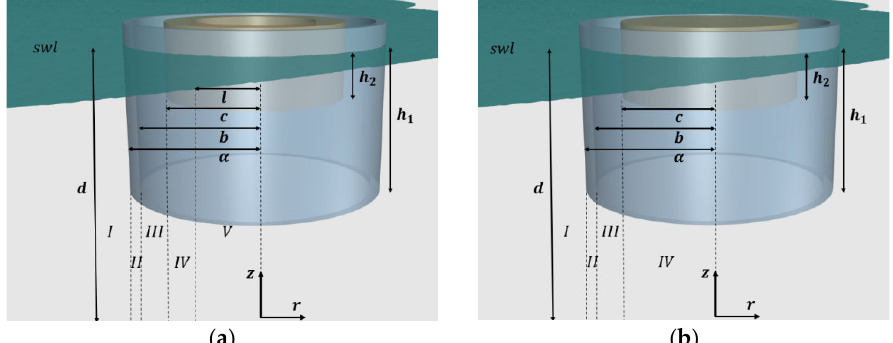
Figure 1. Two examined moonpool case studies exposed to the action of regular wave trains. Definitions and discretization of the flow field around the bodies: ( a ) two coaxial surface piercing moonpool vertical toroidal cylinders; ( b ) moonpool with a coaxial surface piercing truncated circular cylinder.